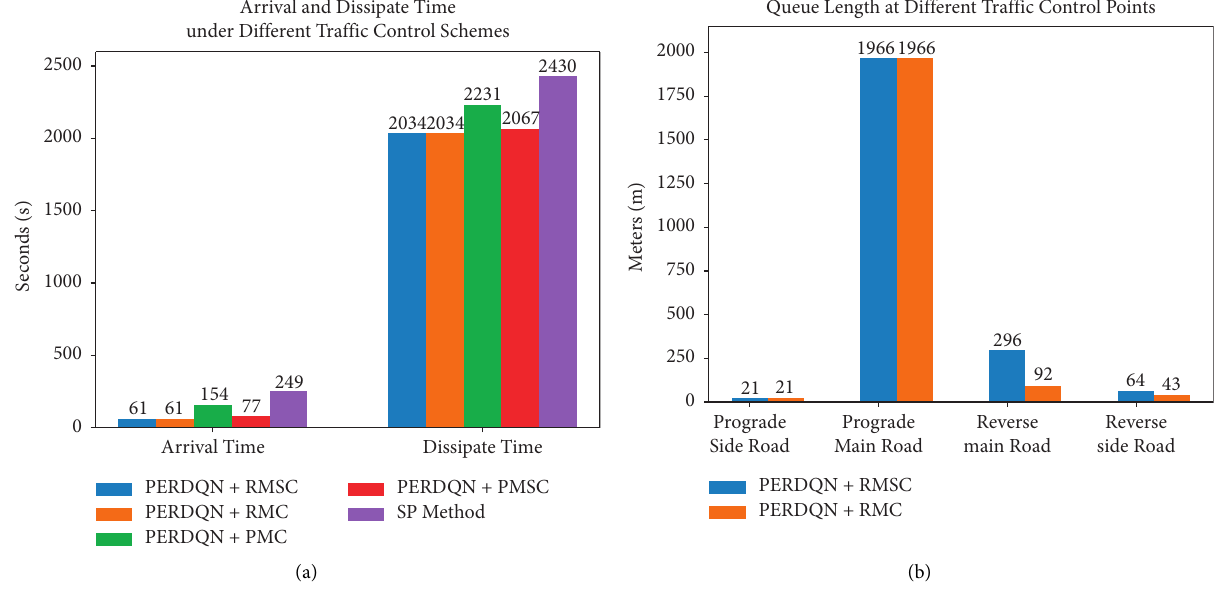
Figure 5: Evaluation parameters of different paths planned by PERDQN and SP under different traffic control schemes in case 1. (a) The arrival time and dissipation time of vehicle queue under different traffic control schemes. (b) Queue length of scheme 1 and scheme 2 at different traffic control